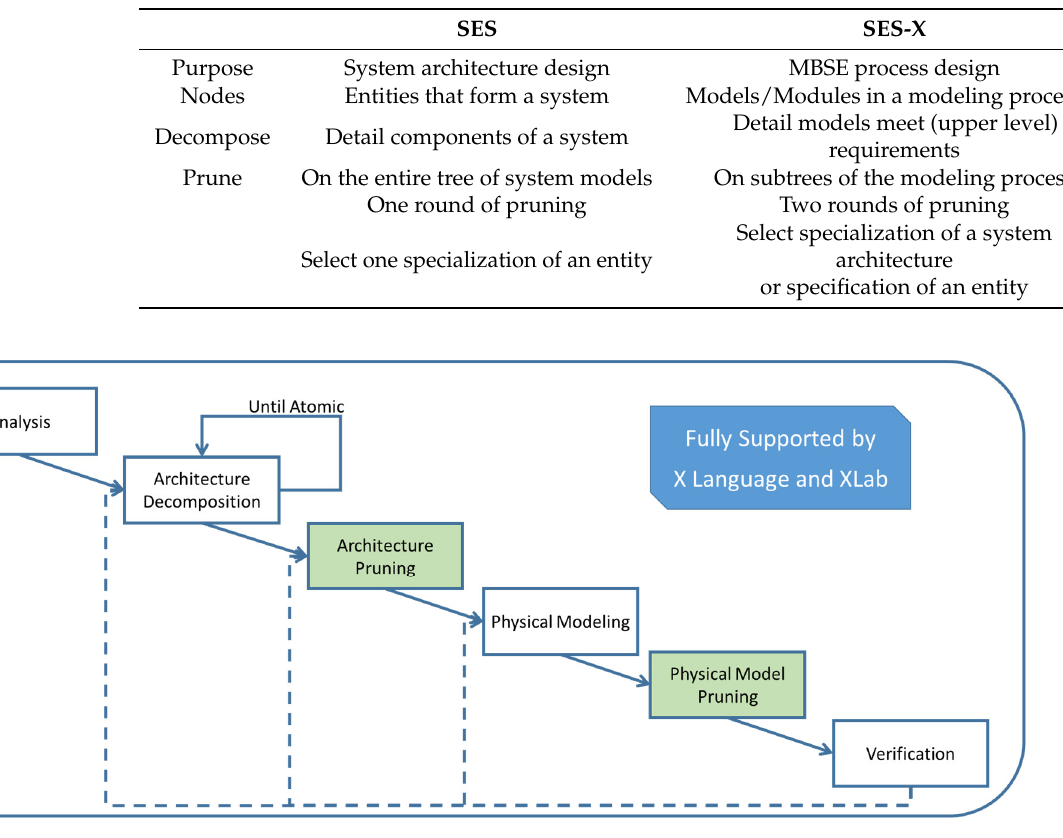
Figure 3. SES-X Modeling and Simulation